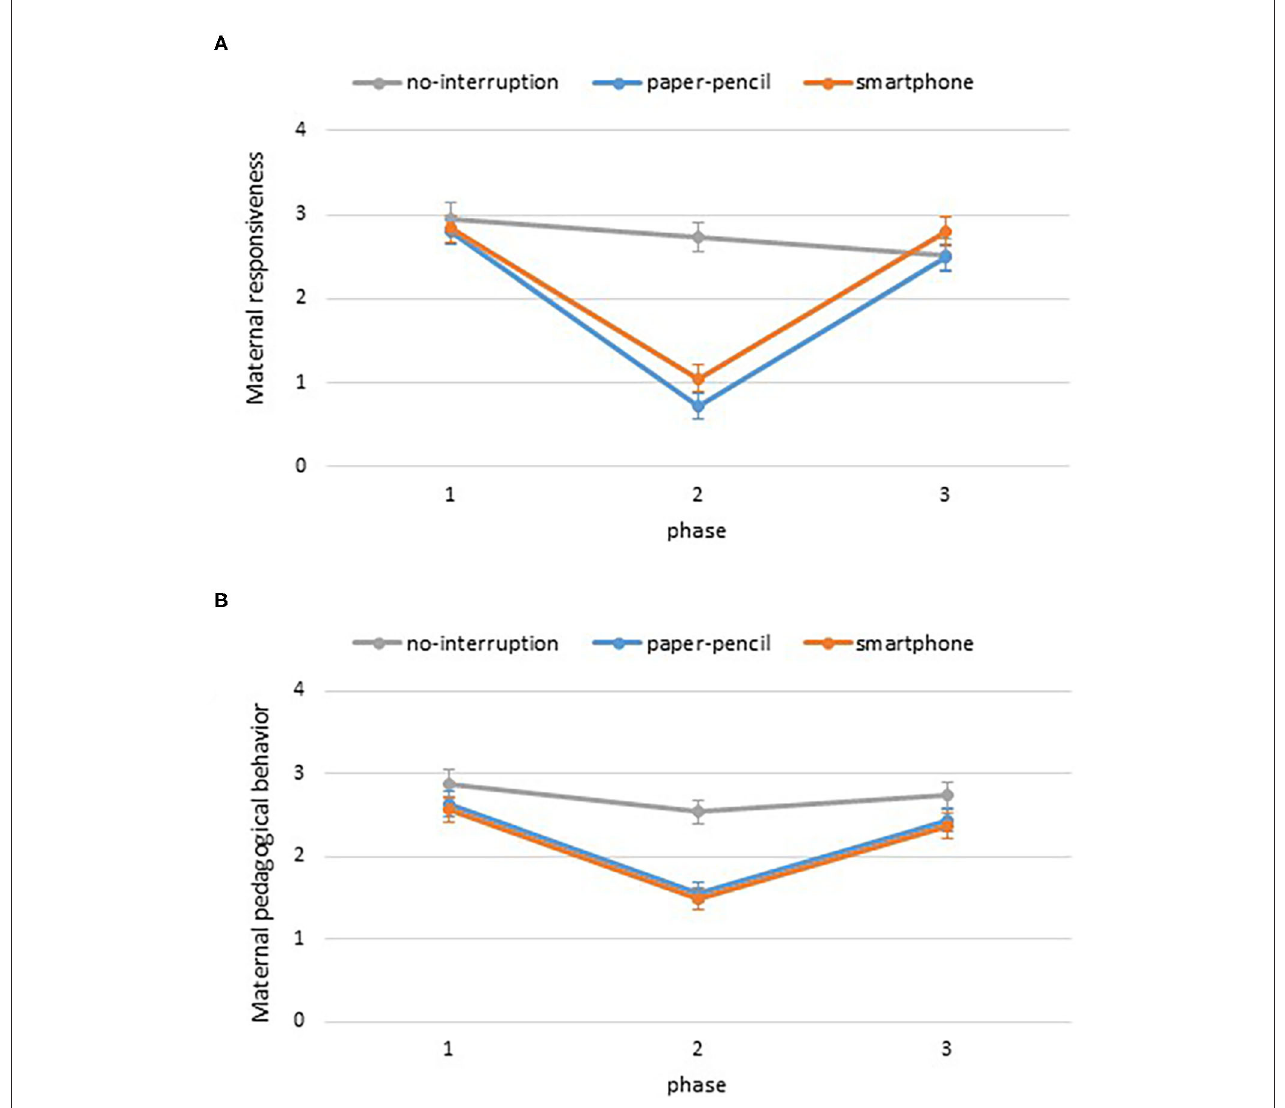
FIGURE 2 | Maternal responsiveness (A) and pedagogical behavior (B) as a function of phase and condition. Error bars are SE of M. * p < 0.05.